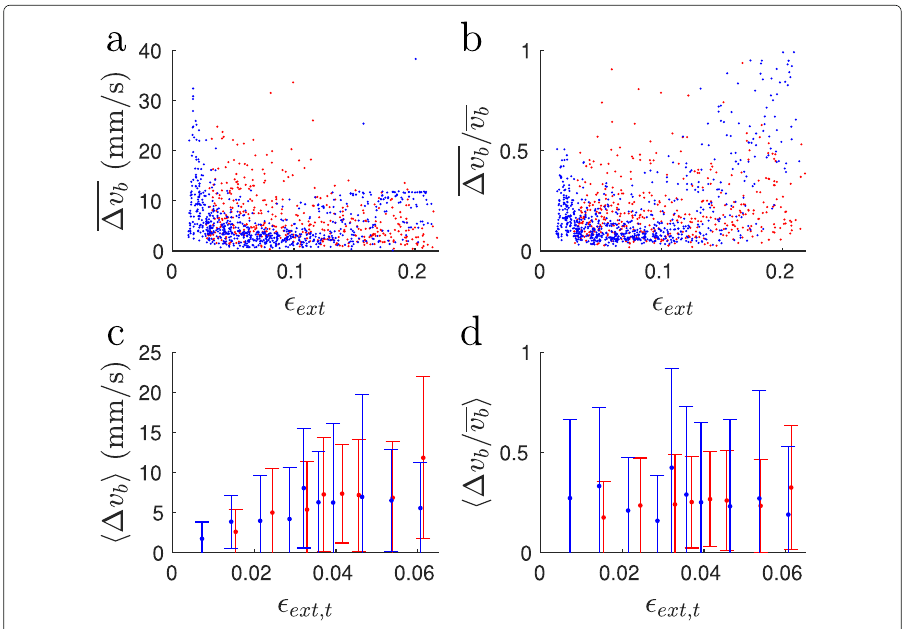
Fig. 4 a Band velocity fluctuations as a function of strain for experiments (red) and simulations (blue). b Same as a but for relative velocity fluctuations. c The average velocity fluctuations as a function of strain rate for experiments (red) and simulations (blue). d Same as c but for average relative velocity fluctuations